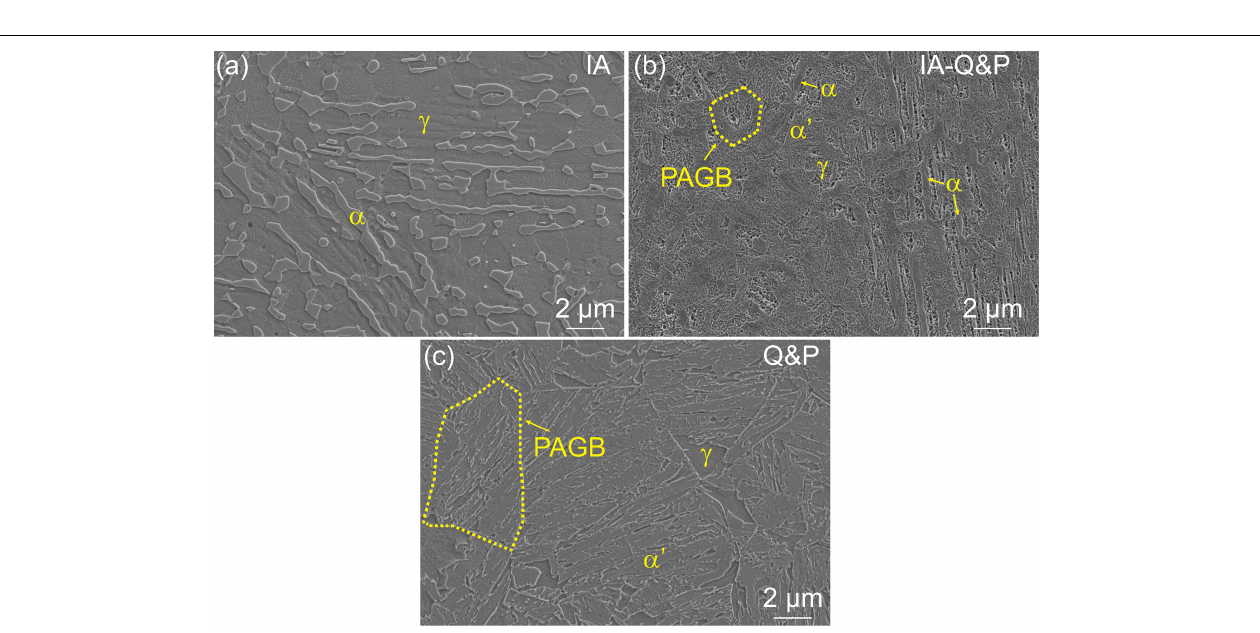
FIGURE 1 | Schematic illustration of the (A) IA, (B) IA-Q&P, and Q&P processing routes, respectively. RT, room temperature.